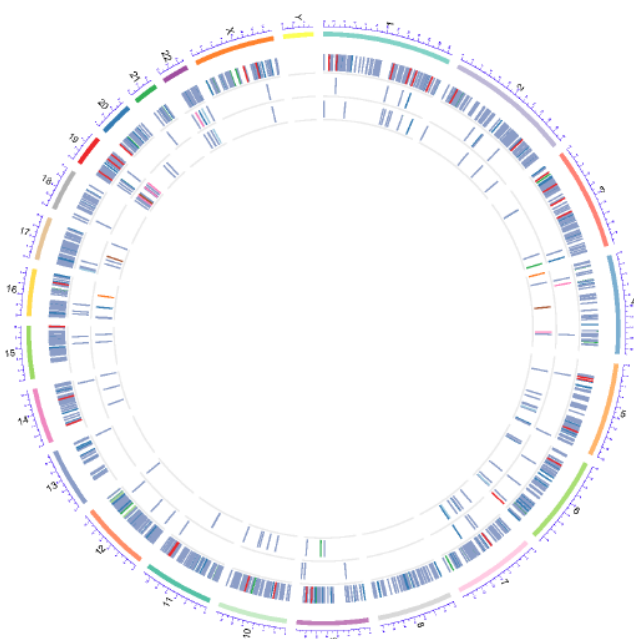
Figure 2. Circos plot of the somatic genetic variants detectable in Lin-/DAPI+/EpCAM+/CK+ CTCs (outer layer), and Lin+/DAPI+/CD14+ (middle layer), and Lin+/DAPI+/CD15+ (inner layer) cell populations selected from blood of a metastatic breast cancer patient via multi-parametric FACS. Int. J. Mol. Sci. 2019 , 20 , x